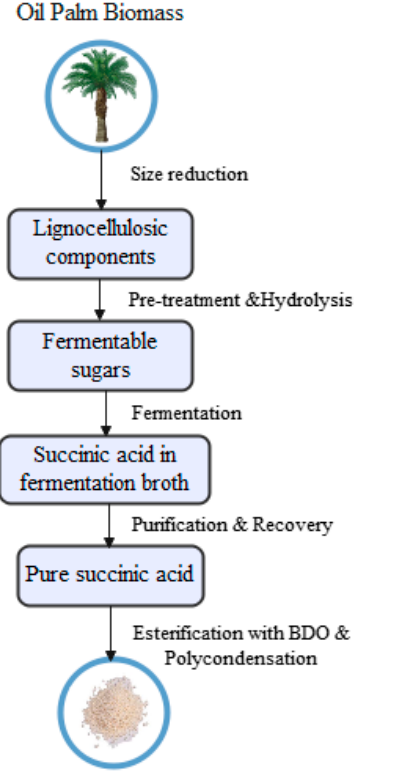
Figure 3. Process flow for the utilization of oil palm biomass for succinic acid and PBS production.